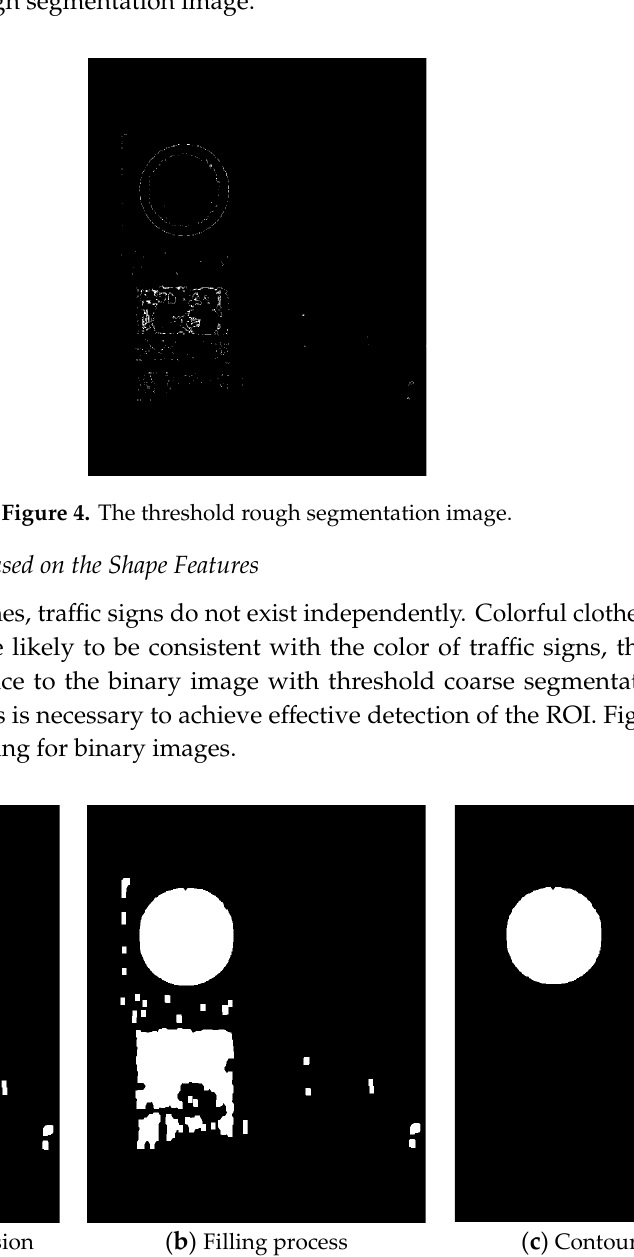
Table 1. HSV color space threshold segmentation ranges.